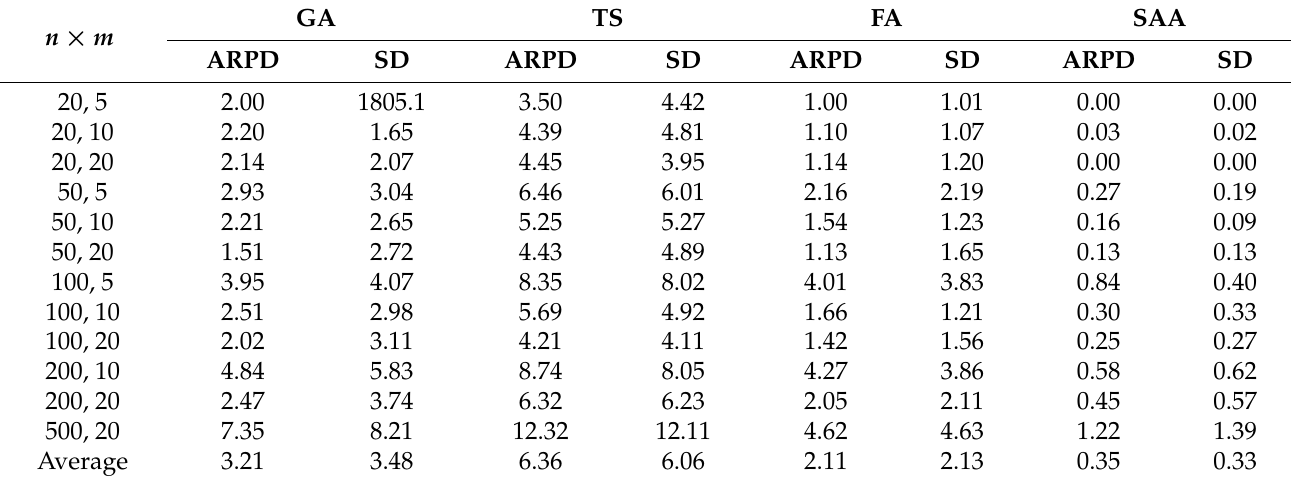
Table 2. Comparison of results obtained by four algorithms with different instances.